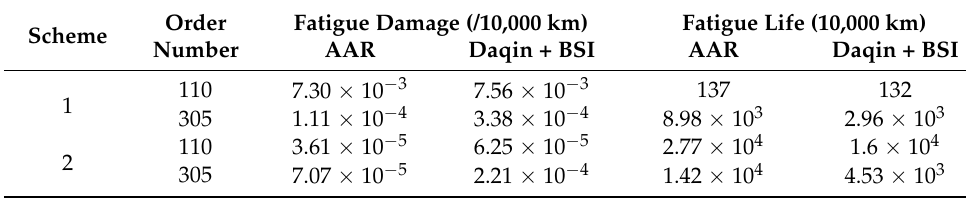
Table 1. Factors and levels of the orthogonal